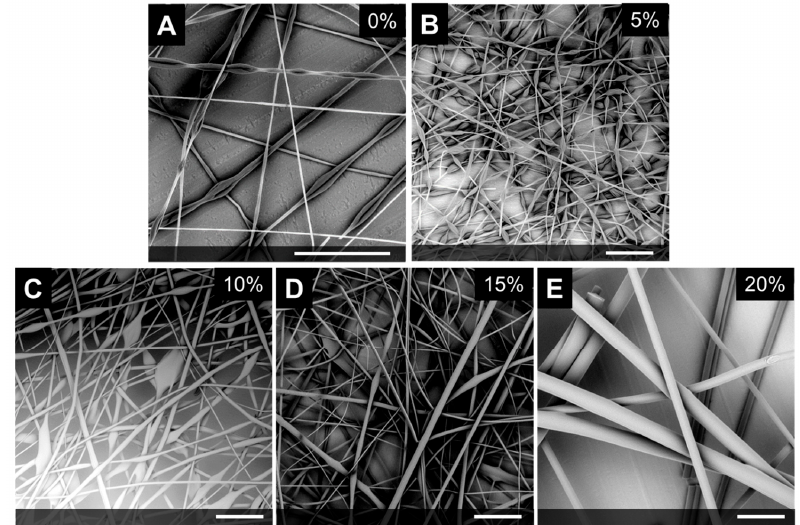
Figure 1. SEM micrographs of 20 wt% PS with increasing amounts of LC using LC -3. The scale bar included is 100 microns in length. Interestingly, ( A ) shows 20 wt.% PS (without LC) forms beaded fibers). Adding small amounts of LC (5 wt.% shown in ( B ), 10 wt.% shown in ( C ), or 15% wt.% in solution shown in ( D )) also produces beaded fibers. A 20 wt.% PS, 20 wt.% LC blend shown in ( E ) forms uniform